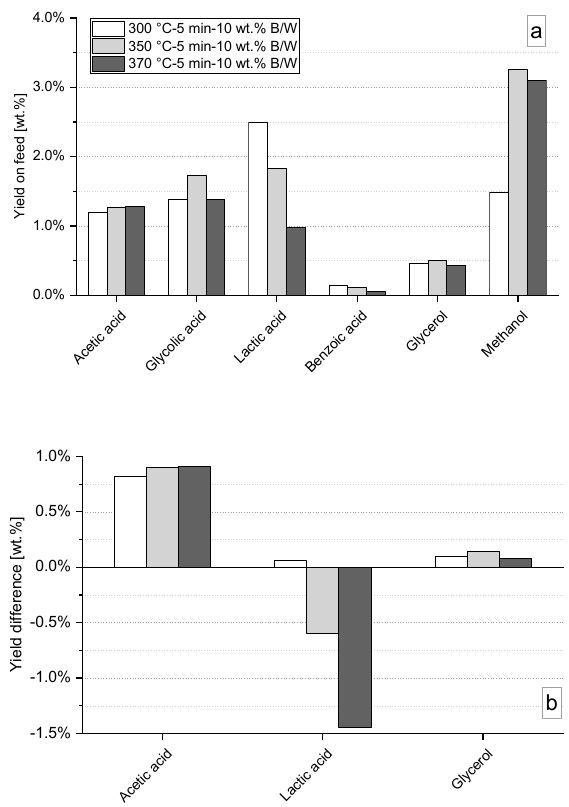
Figure 6. (a) Effect of reaction temperature on yields of specific acids and alcohols species; (b) difference plot for acids degradation versus formation compared to the initial acids content in the lignin-rich streams (LRS) slurry for uncatalyzed HTL tests.